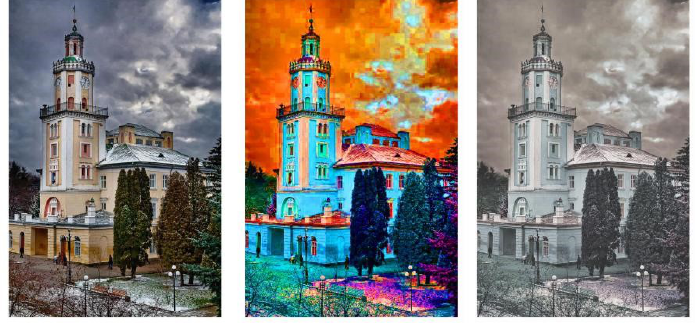
Fig. 1 Legend of visual gaze.